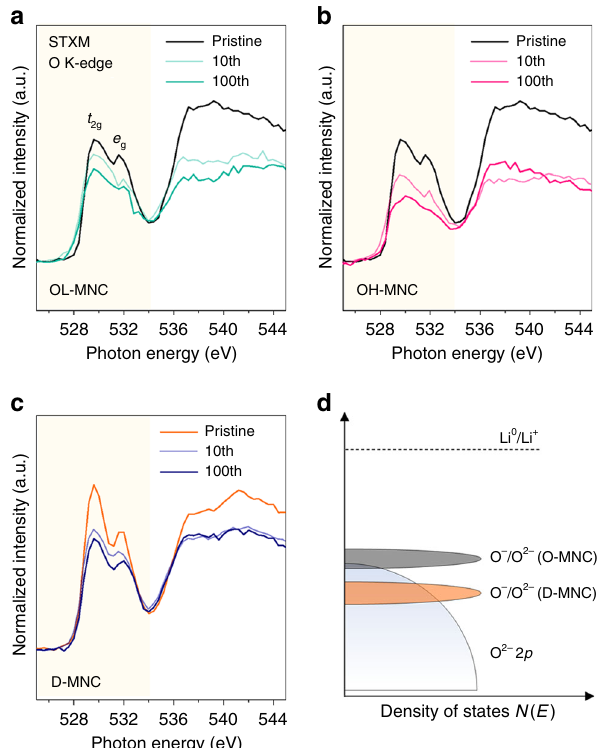
Fig. 3 Oxygen stability of TM-O bonding and electron hole localization on oxygen. Oxygen K-edge SXAS spectrum of a OL-MNC b OH-MNC c D- MNC; the spectra collected on Pristine, 10th cycled and 100th cycled (discharged state) particle. d Schematic diagram of the possible O – /O 2